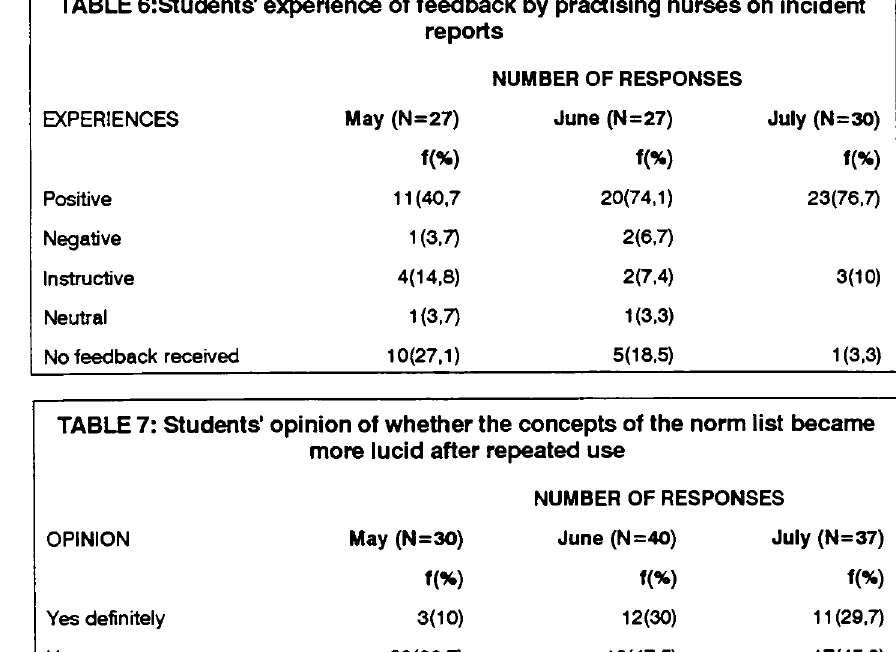
TABLE 7: Students' opinion of whether the concepts of the norm list became more lucid after repeated use